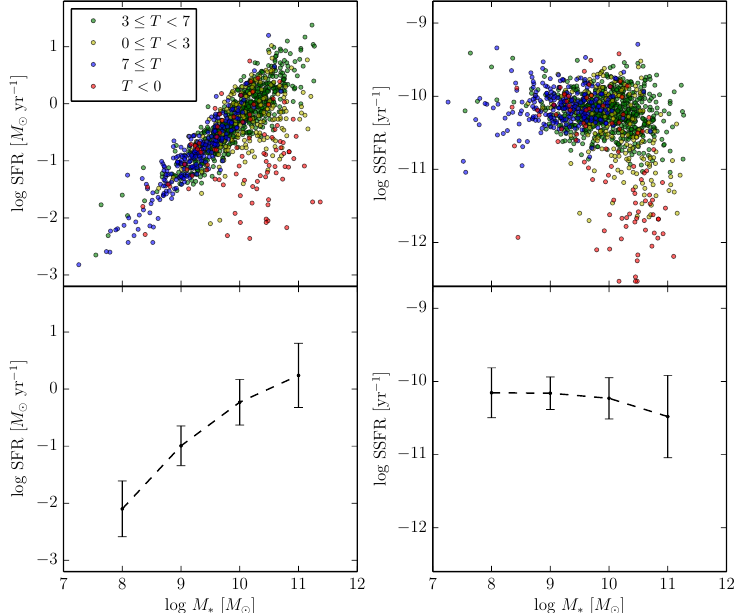
Figure 2. Log of the star formation rate (SFR) ( left panels) and the specific star formation rate (SSFR) ( right panels) as a function of stellar mass. Top panels show the individual galaxies, colour-coded by morphological type, while the lower panels show the median values, with the 1 σ spread indicated by the error bars. The dashed curve connects the points. Morphological type is given as de Vaucouleurs’ T -type, where T < 0 correspond to lenticulars and ellipticals, spirals have 0 < T < 8 , with Sa T = 1 , Sb T = 3 , etc ., and late-type and irregular galaxies are T > 8 . From